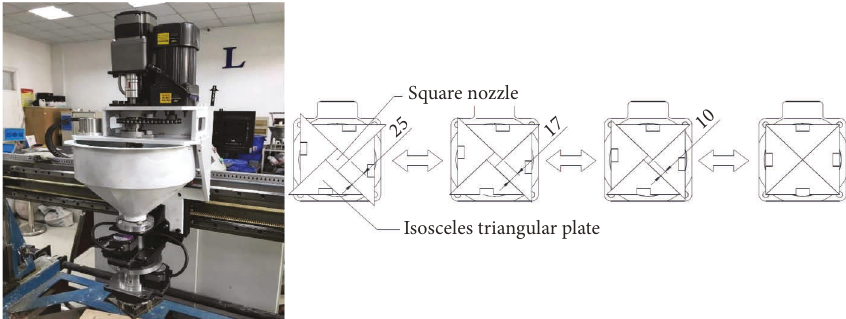
Figure 8: A variable size sprinkler head device and deformation principle